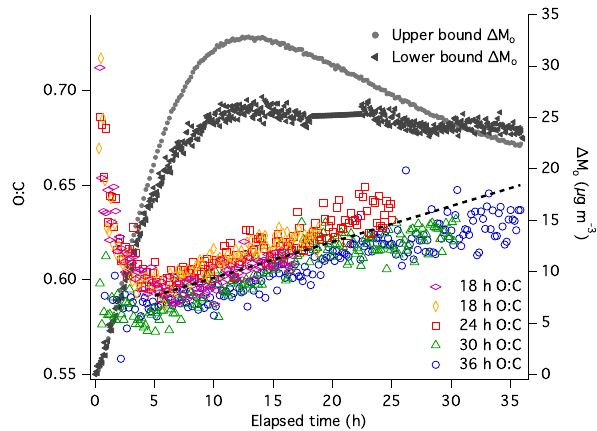
Fig. 3. SOA mass (right axis) and O:C elemental composition (left axis) over 36 h of OH exposure using AS seed. After hour 5, the O:C increases at an average rate of 0.0019 h − 1 (dashed line).